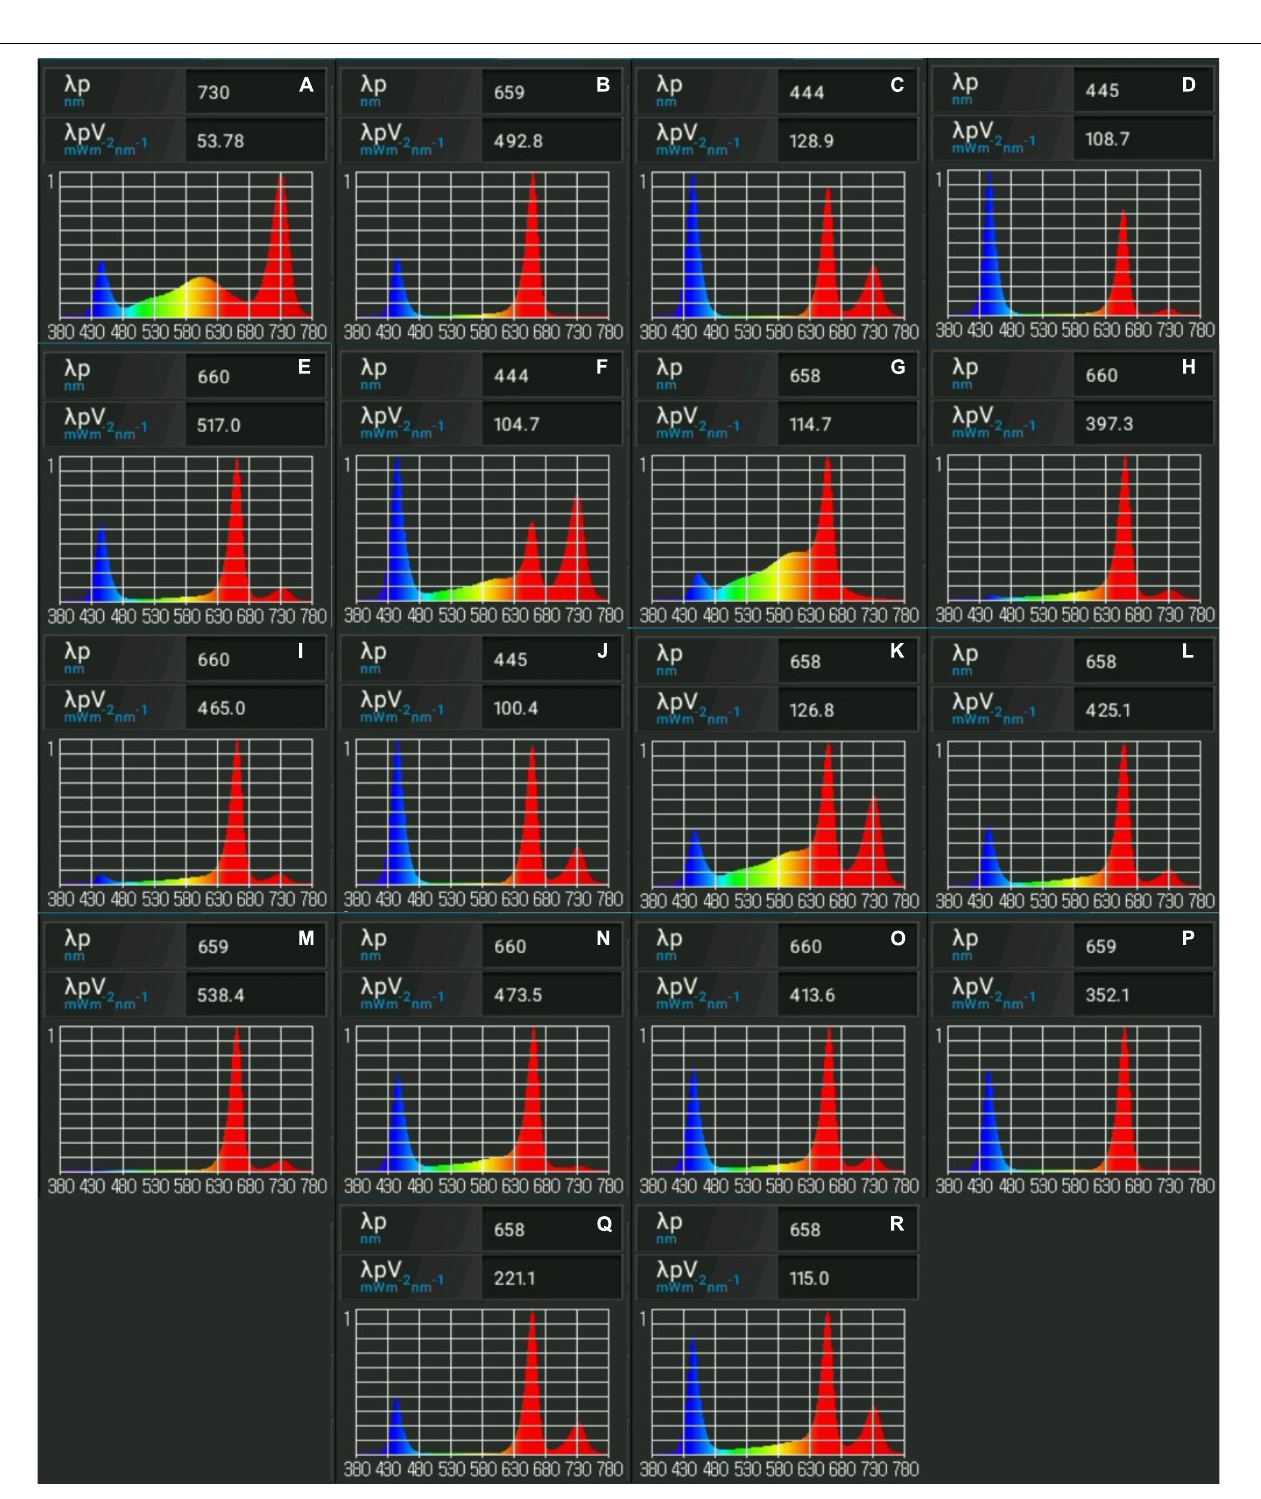
FIGURE 4 | Spectral analyses of light treatments from the validation experiment. Images demonstrate relative amounts of fluencies emitted per treatment. Light spectra presented were obtained using Li-Cor LI-180 spectrometer. Presented are optimized light treatments for (A) genetic algorithm (GA) shoot length, (B) GA canopy surface area, (C) GA number of shoots, (D) GA number of nodes, (E) biogeography-based optimization (BBO) canopy surface area, (F) BBO shoot length, (G) interior search algorithm (ISA) shoot length, (H) ISA number of nodes, (I) ISA root length, (J) ISA number of shoots, (K) symbiotic organisms search (SOS) shoot length, (L) ISA canopy surface area, (M) SOS root length, (N) BBO number of nodes, (O) SOS canopy surface area, (P) SOS number of nodes, (Q) BBO number of shoots, and (R) SOS number of shoots.